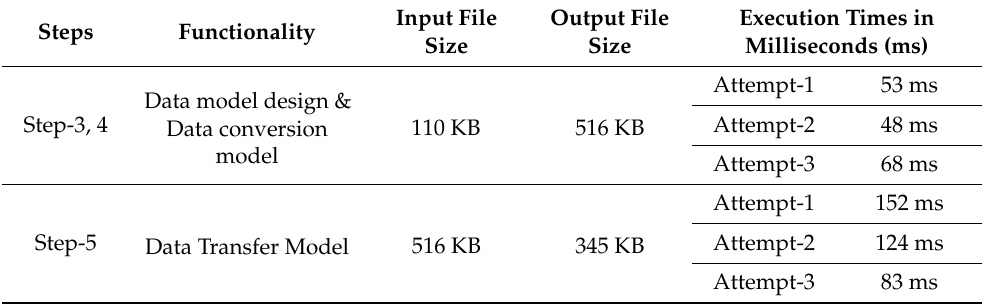
Table 1. Execution times for the functionality Data model design, conversion and transfer model.